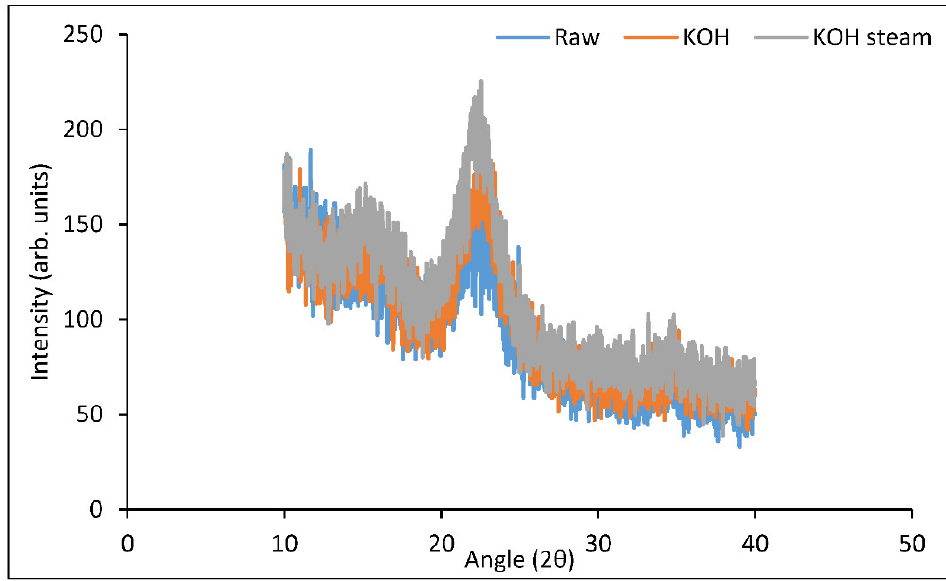
Figure 4. XRD analysis of B. ceiba substrate pretreated with KOH and KOH followed by steam.